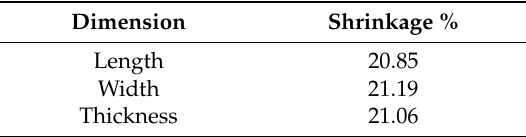
Figure 11. XRD patterns of the printed sample and the sintered sample with heating rate (3 °C/min), highest temperature (1083 °C), and holding time (3 h). Table 8. Dimensional shrinkage of specimens.